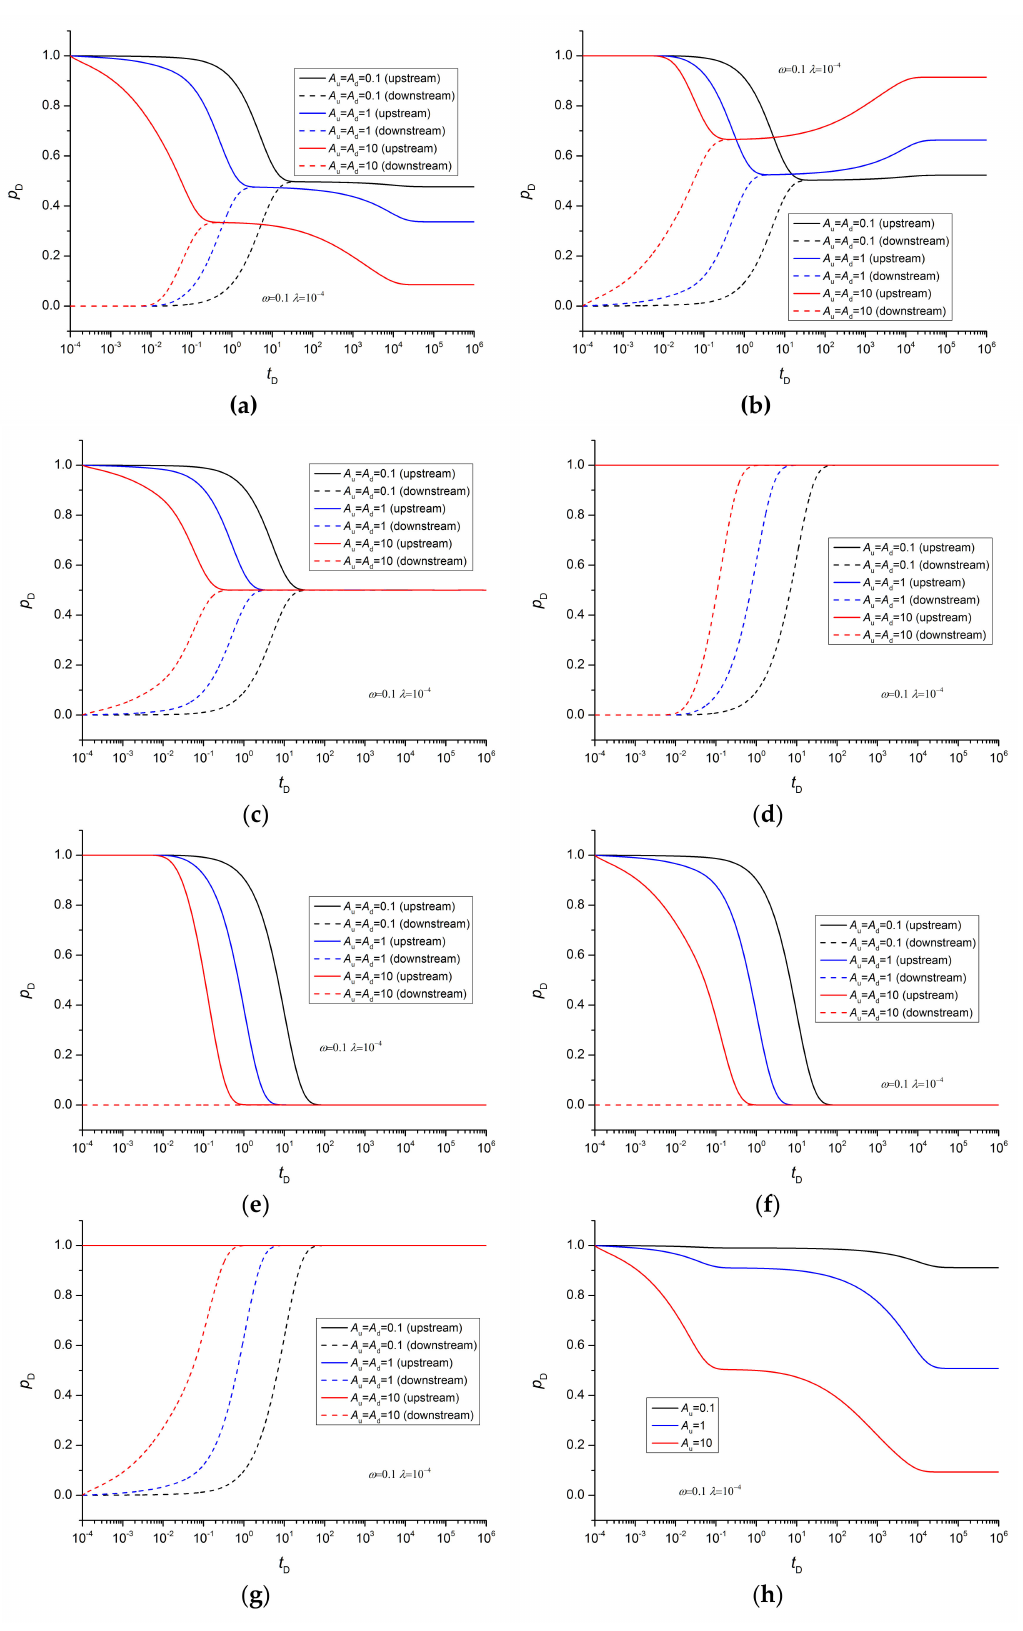
Figure 5. Pressure curves of dual-medium cores for di ff erent pulse decay methods: ( a ) UPP; ( b ) DNP; ( c ) UPDNP; ( d ) UCPIS; ( e ) DCPRS; ( f ) UPPDCP; ( g ) UCPDNP; ( h )